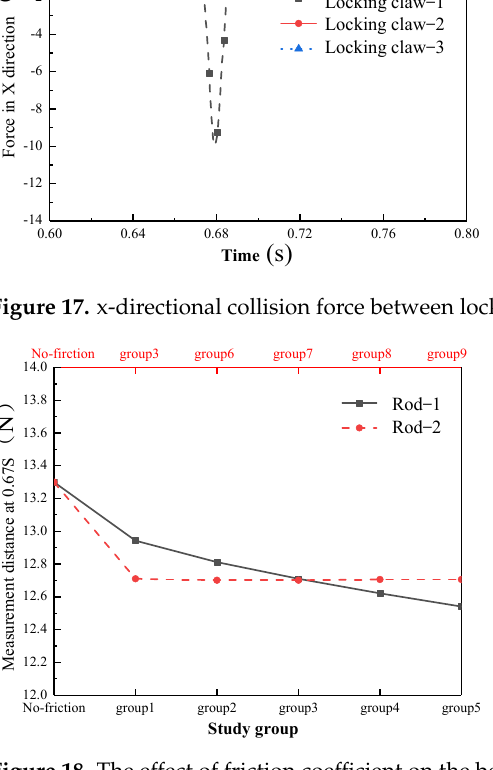
Figure 18. The effect of friction coefficient on the bounce distance of locking process.